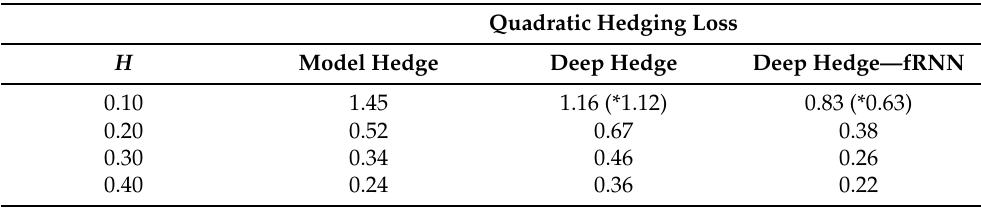
Table 3. Comparison of the quadratic loss between model and deep hedges with fRNN architecture trained on 75 epochs for different H .